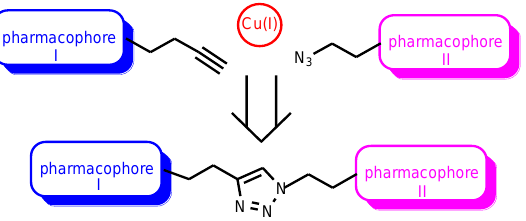
Figure 1. Copper-catalyzed cycloaddition reaction of organic azides to terminal acetylene- “click” reaction.